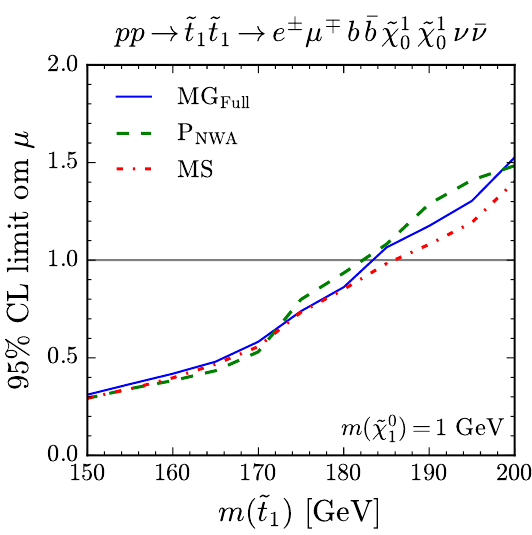
Figure 9 . We show the 95% CL limit on the signal strength when the stops are decayed using the three approximations given in table 1. Beyond the discontinuity around the threshold, there is little di(cid:11)erence in the excluded